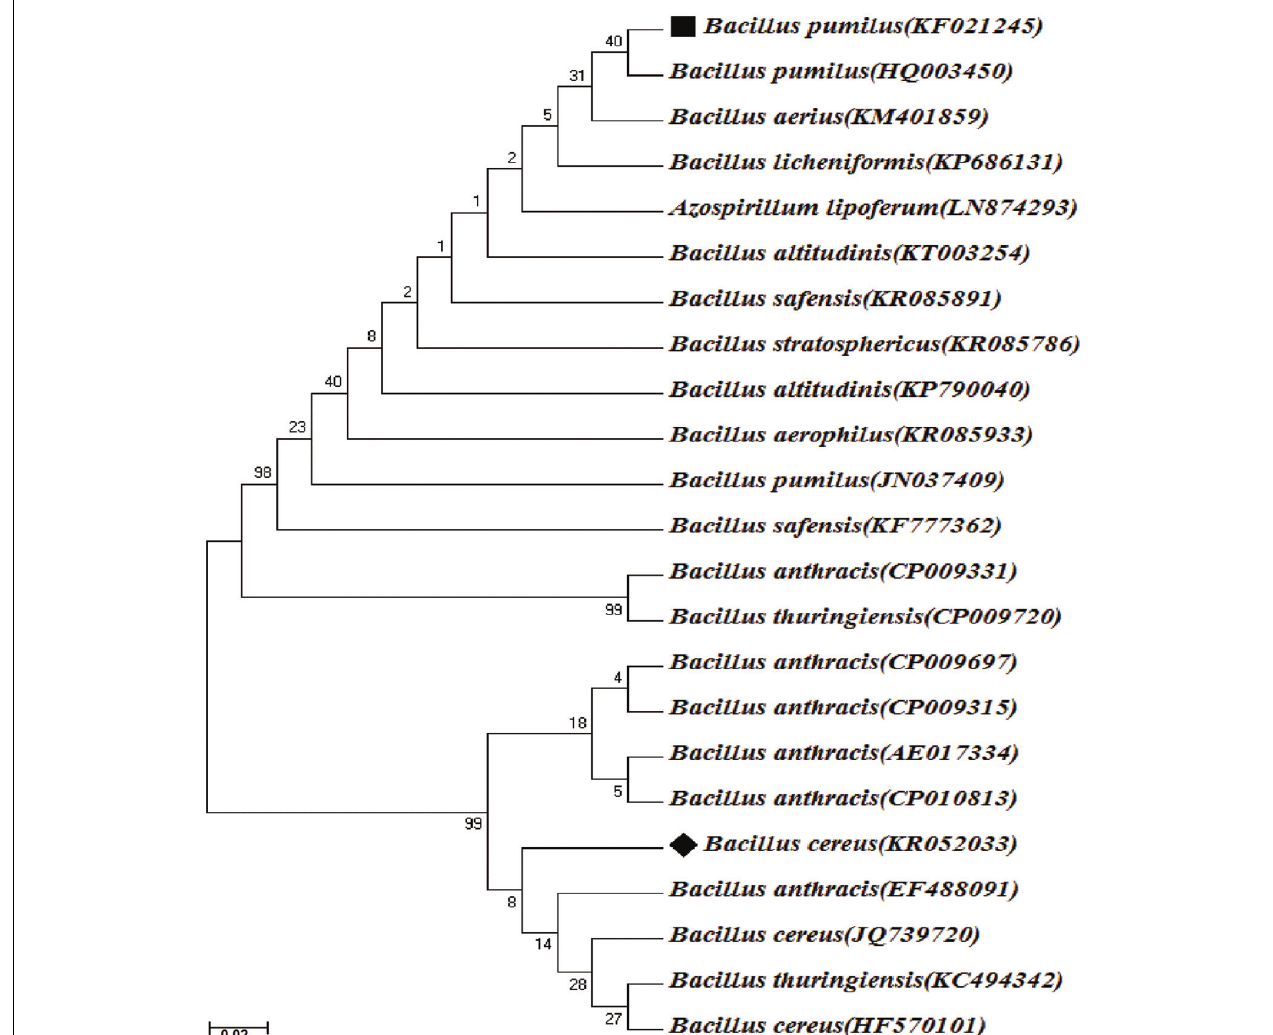
FIGURE 2 | Phylogenetic tree of Bacillus pumilus strain KS2 and B. cereus strain R2 based on 16S rDNA sequencing and their closest relatives. Bar 0.02 nucleotide substitutions, values in parenthesis denotes GenBank accession number. ∗ Bootstrap values (expressed as percentages of 1000 replications) are shown at branch